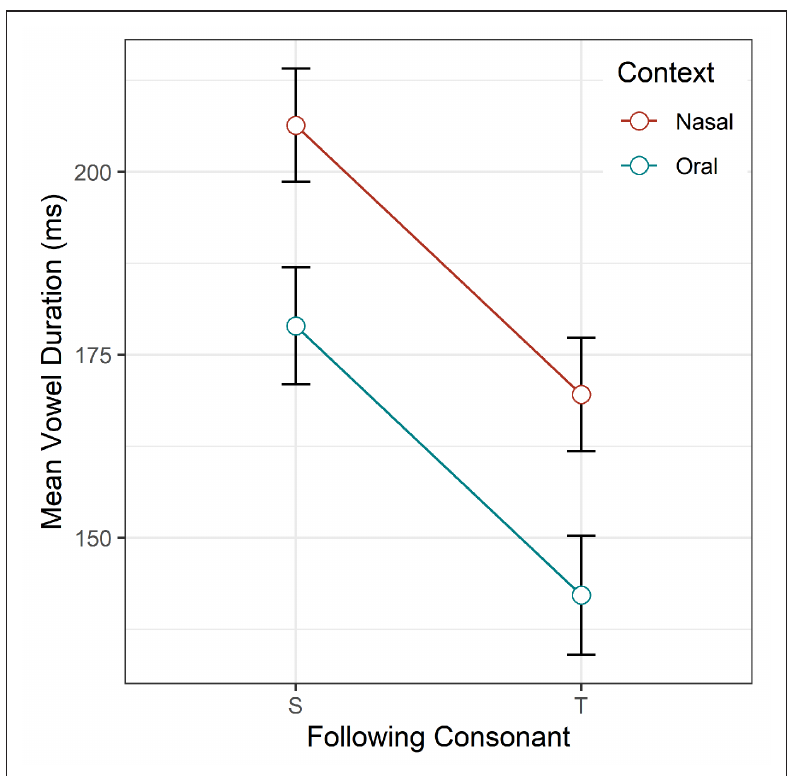
Figure 4: Mean vowel duration (ms) estimates in oral versus nasal context before [t] or